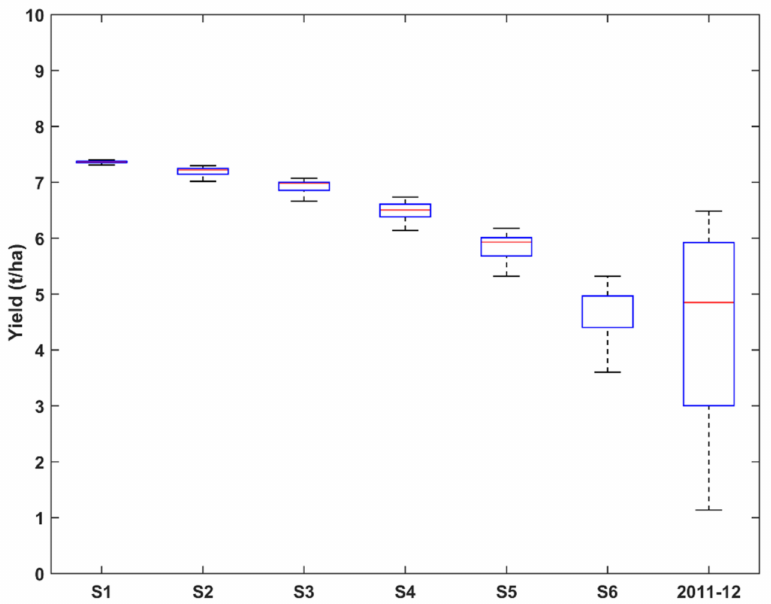
Figure 13. Variation of grain yield (t/ha), between simulated scenarios and the real case (2011–2012 agricultural season) based on the NDVI profiles (1st approach). The statistical Student’s t -test shows that S1 and S2 are identical ( p > 0.05), and the other scenarios are significantly different ( p ≤